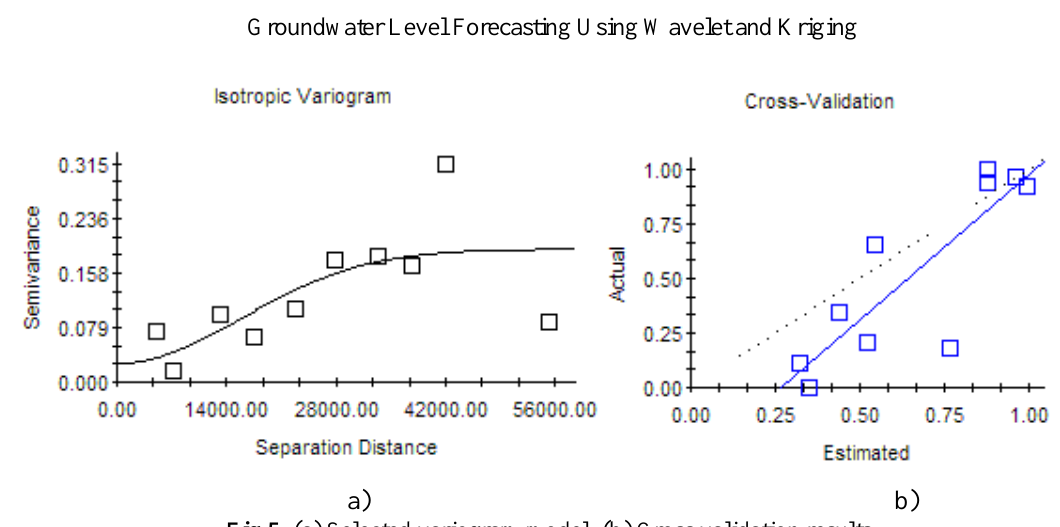
Fig 5. (a) Selected variogram model. (b) Cross validation results.